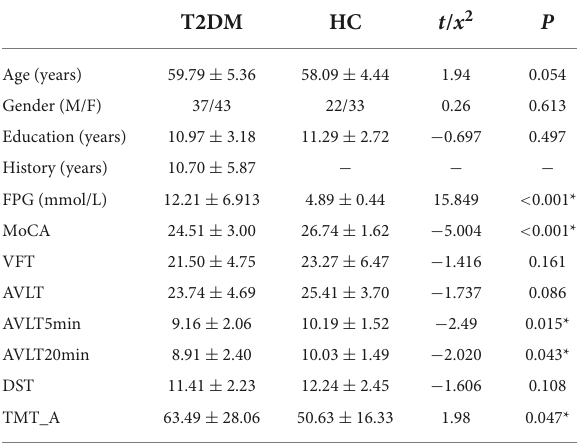
TABLE 1 Comparison of general dates between patients with T2DM and